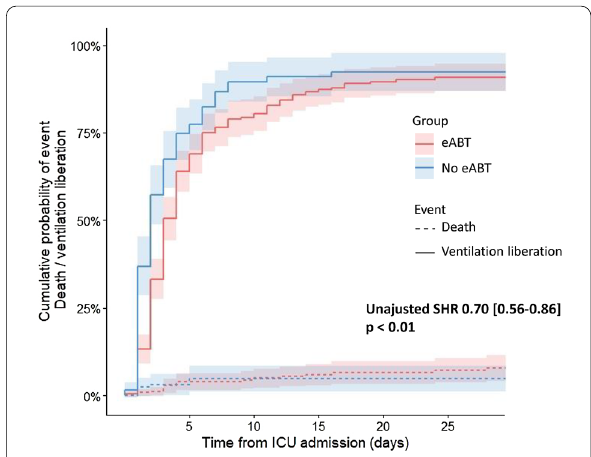
Fig. 2 Cumulative incidence of successful weaning from mechanical ventilation and death according to eABT. eABT was the first line of antibiotic therapy introduced during the first 24 h of ICU admission. Continuous lines are cumulative incidence function curves of the probability of being successfully weaned from mechanical ventilation modelled with univariate Fine and Gray regression accounting for the competitive risk of death, with eABT as the independent variable. Broken lines are cumulative incidence function curves of the probability of dying in the ICU. Shaded areas are 95% confidence intervals. eABT early antibiotic therapy, SHR subdistribution hazard